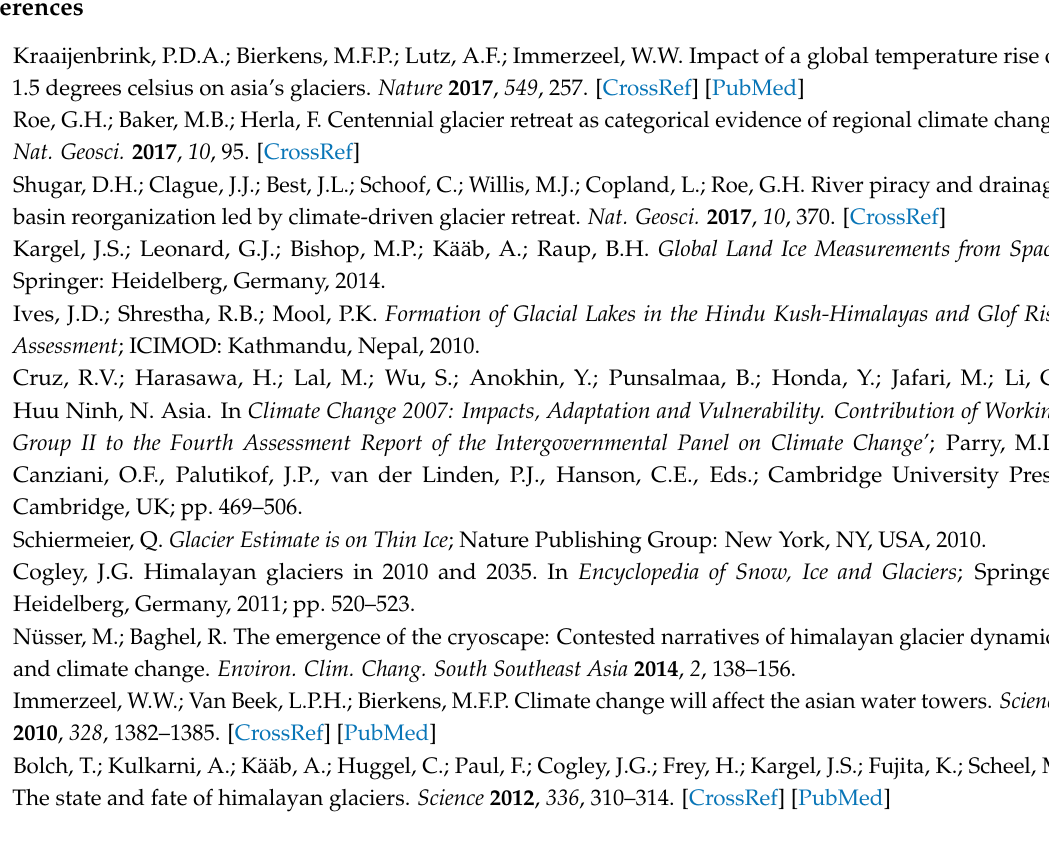
Figure S1: A color composite of a time series of Landsat satellite images showing the growth of Imja Lake from 1975–2016, Figure S2: A color composite of a time series of Landsat satellite images showing the growth of Lower Barun Lake from 1975–2016, Figure S3: A color composite of a time series of Landsat satellite images showing the growth of Thulagi Lake from 1973–2016, Figure S4: Centerline lake transect, Figure S5: Icebergs in Thulagi Lake. Photographs by J. Kargel, 30 October 2017, Figure S6: (a,b) Field photographs showing vegetation on an ice-cored end moraine. (c,d) Bird’s eye view of Thulagi Lake where a dark-colored end moraine is reflecting some of the vegetation growth. Photographs by J. Kargel, 3 May 2013, Figure S7: Upper Barun Lake and possible flood route in case of an outburst, Figure S8: Imja Lake-lowering project (a–d) and part of a warning siren network (e), Table S1: List of Landsat satellite imageries used in this